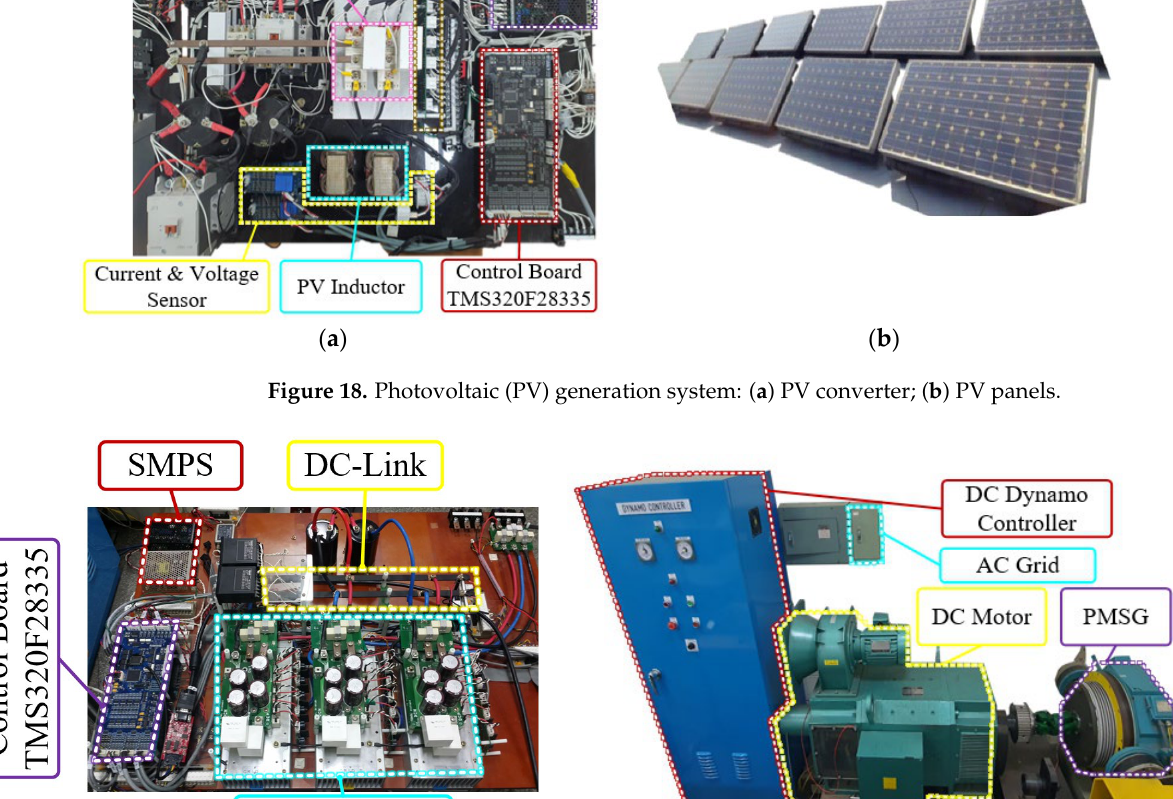
PV panel was used.